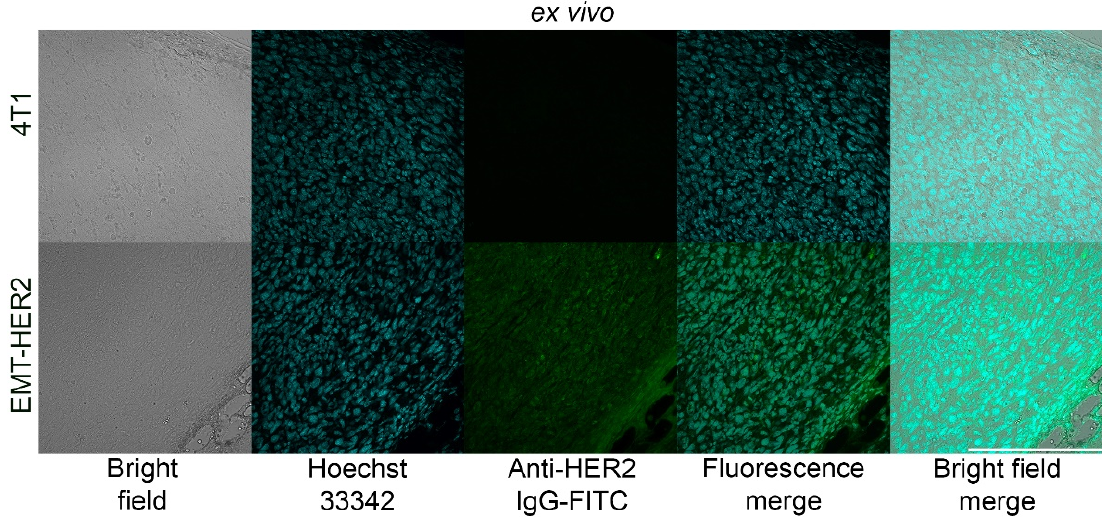
Figure 4. Ex vivo imaging of HER2 expression in EMT-HER2 tumors. Tumors were excised, and cryosections were stained with Hoechst33342 and anti-HER2-FITC IgG followed by confocal laser scanning microscopy analysis in bright field and fluorescence channels, corresponding to Hoeschst33342 and FITC fluorescence. 4T1 tumors with no HER2 expression served as the negative control. Scale bar, 250 μ m.